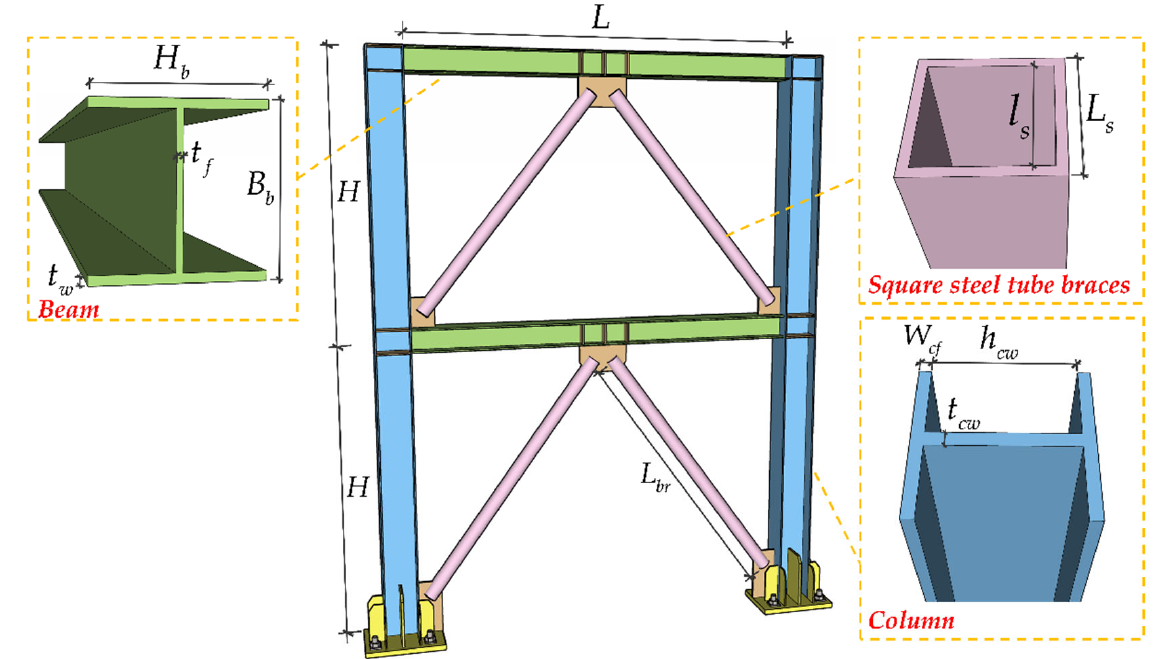
Figure 3. The parameters of a square steel tube brace.